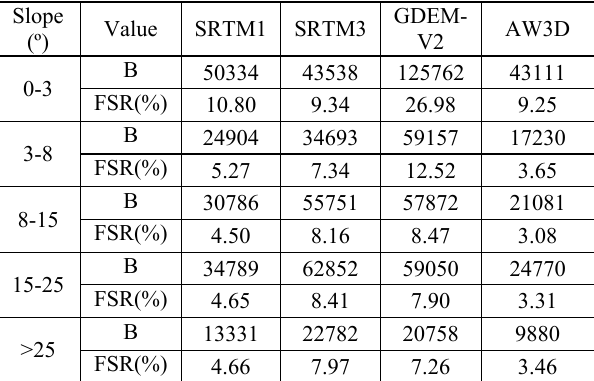
Table 4. B and FSR values of typical DEM datasets